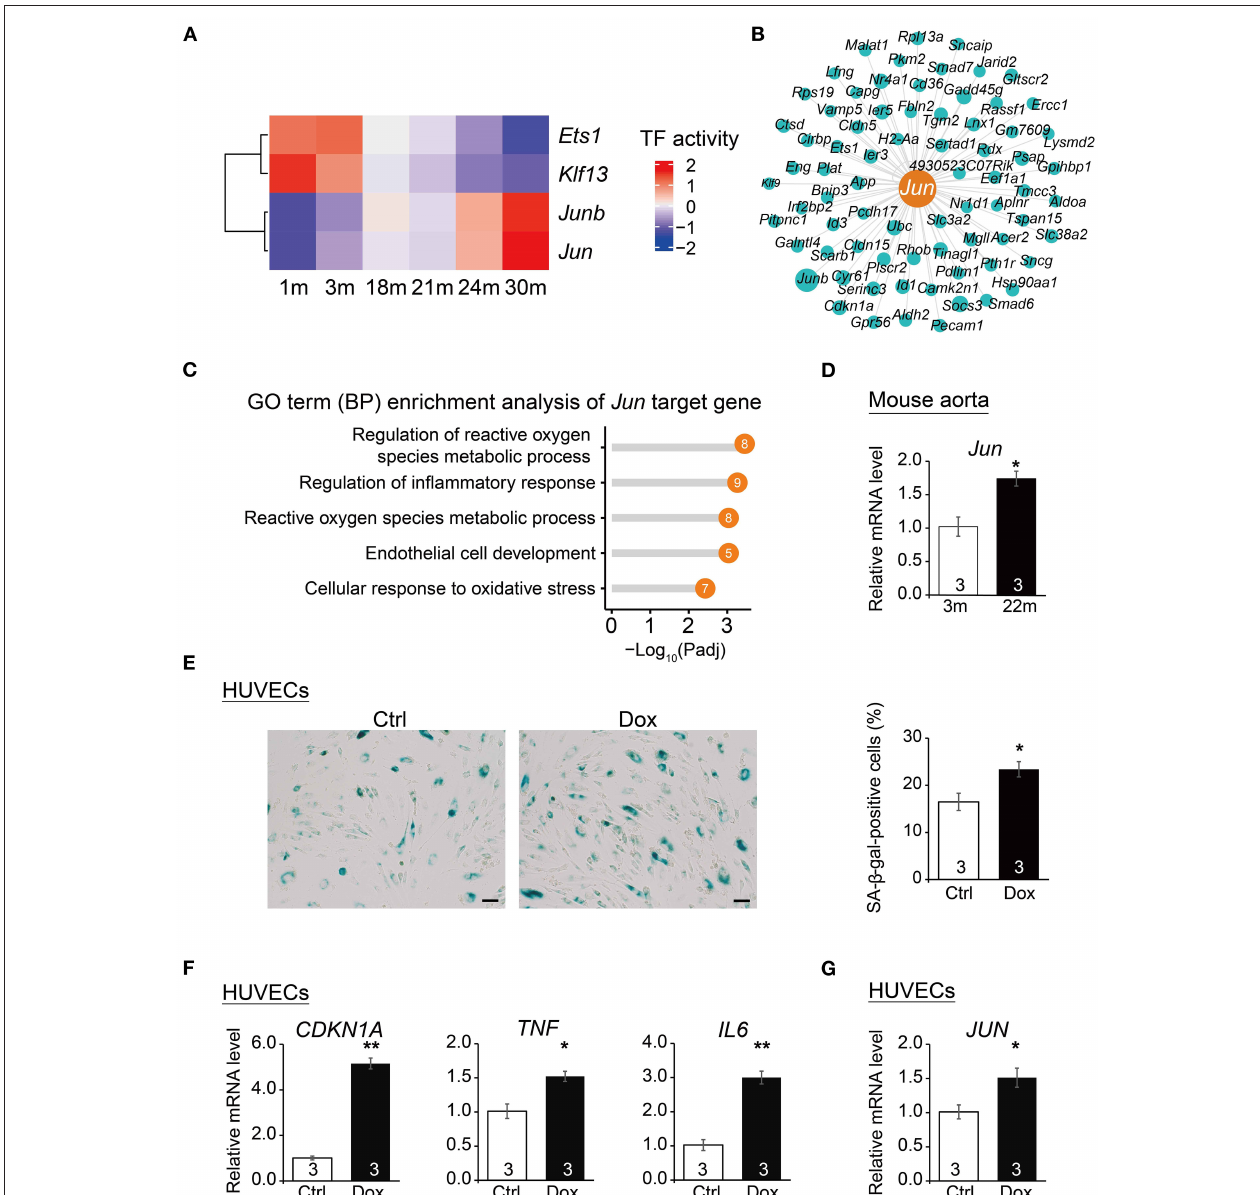
FIGURE 5 | Transcription regulatory network analysis uncovers Jun as a regulator of vascular aging. (A) Heatmap of transcription factor (TF) activities at six time points. (B) Gene network showing target genes of Jun . The dot size presents relative weight values in the regulatory network. (C) Lollipop chart showing enriched GO pathways of Jun target genes. (D) qRT-PCR analysis of Jun mRNA levels in young (3m) vs. aged mouse (22m) aorta. Data are presented as the mean ± SEM ( n = 3) biological repeats. * p < 0.05 (Student’s t- test). (E) SA- β -gal staining in HUVECs treated with vehicle (Ctrl) or Dox (doxorubicin). Data are presented as the mean ± SEM ( n = 3 independent experiments). * p < 0.05 (Student’s t- test). Scale bar, 50 µ m. (F) qRT-PCR analysis of mRNA levels of aging markers in HUVECs upon Dox treatment. Data are presented as the mean ± SEM ( n = 3 independent experiments). * p < 0.05, ** p < 0.01 (Student’s t- test). (G) qRT-PCR analysis of JUN